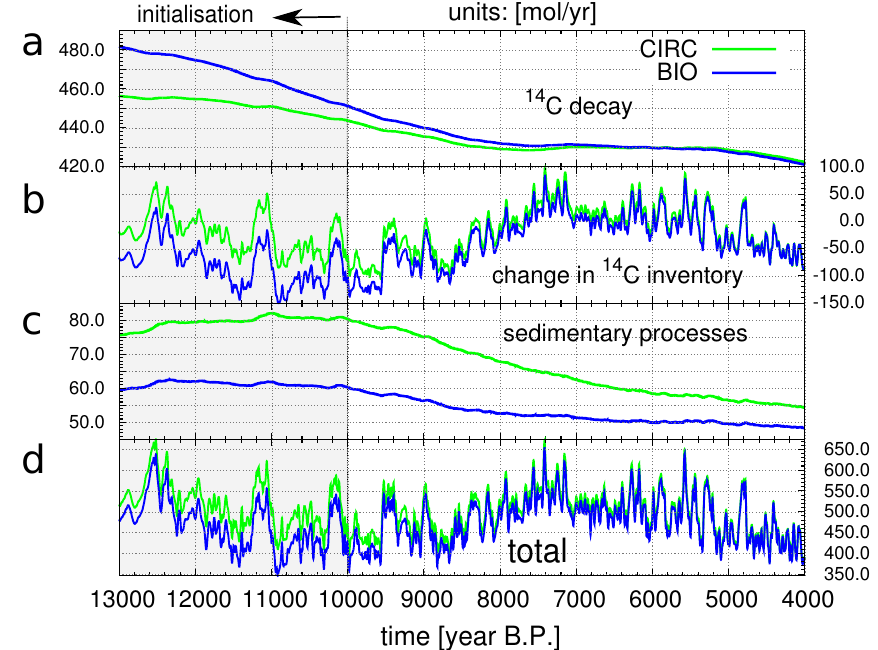
Fig. 9. The oceanic 14 C budget for the experiments BIO and CIRC for the period 13 to 4kyrBP. (a) Decay of the data-normalised inventory of 14 C in the form of inorganic and organic carbon, (b) changes in whole ocean radiocarbon inventory, and (c) contribution from sediments (burial flux and decay of 14 C within the active sediment layer). (d) After 4kyrBP, the two experiments do not show significant differences in the total ocean and sediment 14 C loss.